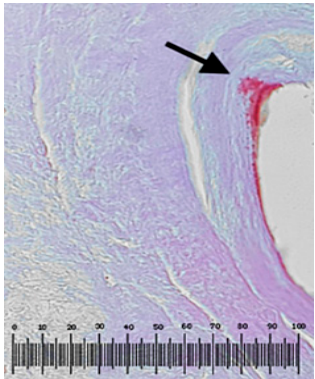
Figure 12. Rigid ecaudate arteriosum (concentric and predominantly left) fibrosis and calcifications (marked by arrow) that have surrounded one of the stents taken; the polarized light exam did not reveal fragments from the stent in peripheral tissue; hematoxylin–eosin staining; magnification × 200.